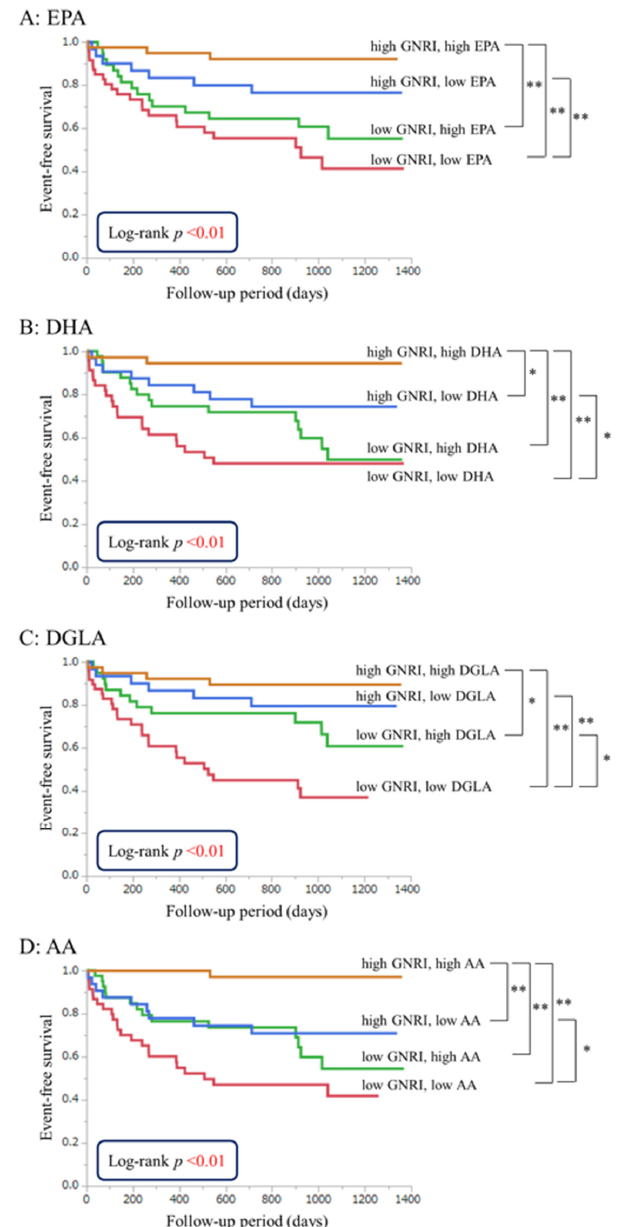
Figure 2. Event ‐ free survival curves for all ‐ cause death in patients with acute decompensated heart failure (ADHF). Unadjusted cumulative event rates for the primary endpoint (all ‐ cause death) were estimated using the Kaplan ‐ Meier method and compared between groups using the log ‐ rank test. The patients were categorized into four groups on the basis of the median PUFA levels in the high ‐ GNRI (no or low risk; GNRI ≥ 92.0) and low ‐ GNRI (moderate or high risk; GNRI <92.0) groups. ( A ) eicosapentaenoic acid (EPA), 40.2 μ g/mL; ( B ) docosahexaenoic acid (DHA), 109.5 μ g/mL; ( C ) dihomo ‐ gamma ‐ linolenic acid (DGLA), 21.5 μ g/mL; and ( D ) arachidonic acid (AA), 145.0 μ g/mL. * p < 0.05; ** p < 0.01.